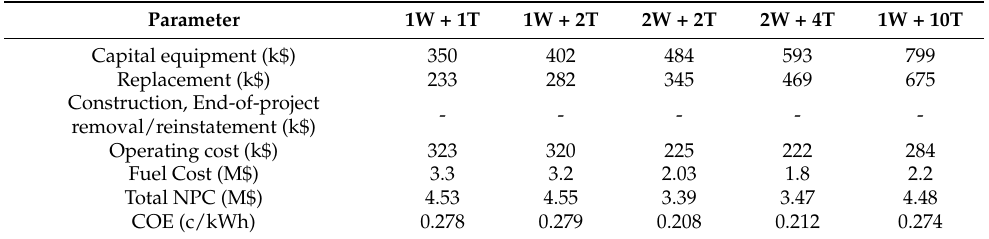
Table 14. Financial analysis